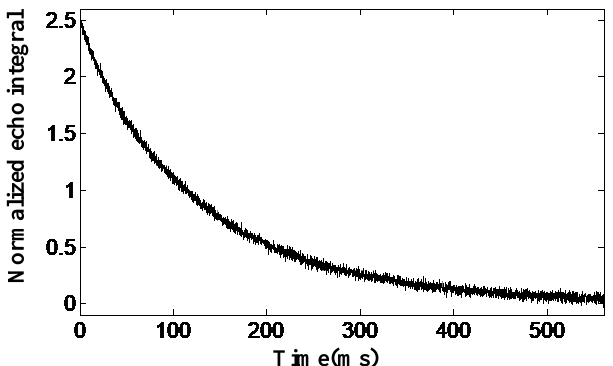
Figure 9. CPMG echoes the envelope curve of pure water.